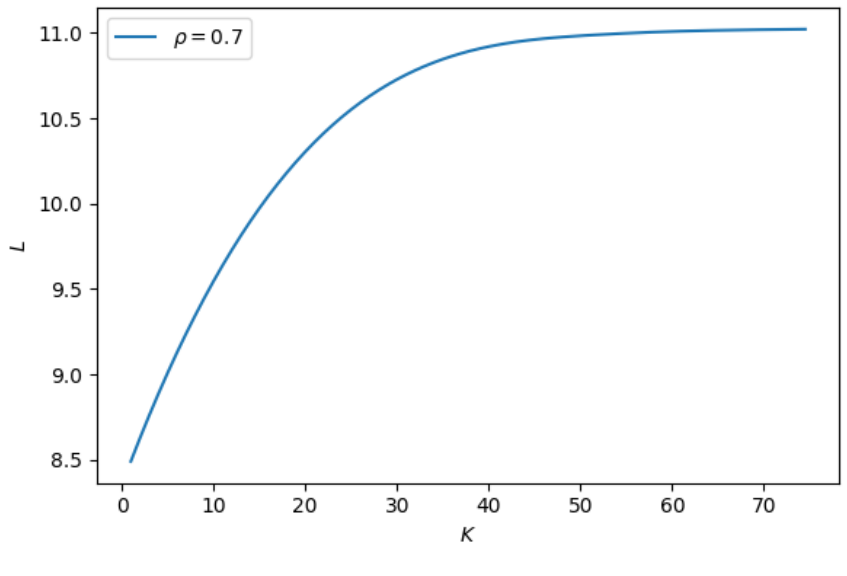
Figure 2. L vs. K for system load ρ =